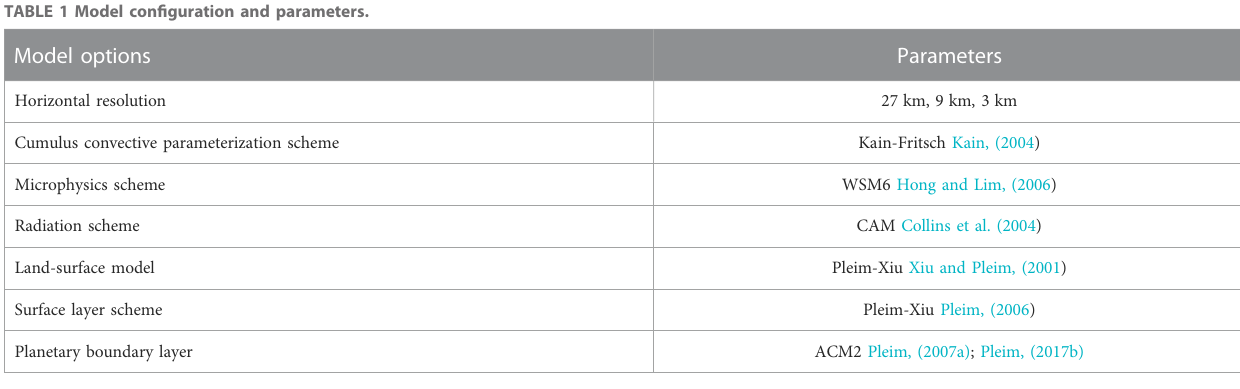
TABLE 1 Model con fi guration and parameters.